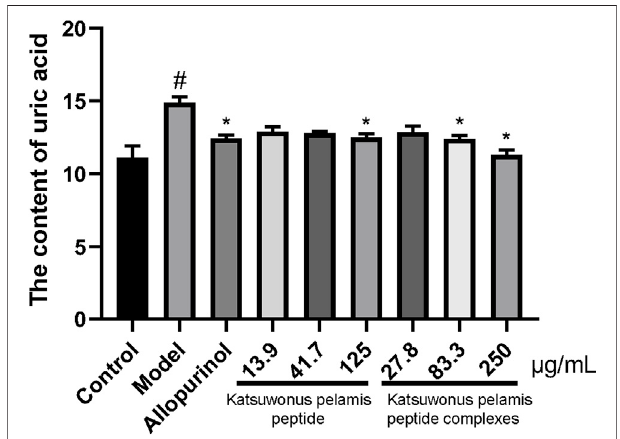
FIGURE1| Effect of Katsuwonuspelamis peptide and its complexes on the UA content in potassium oxonate – induced hyperuricemic zebra fi sh. # p < 0.05 compared with the control group; * p < 0.05 compared with the model group.